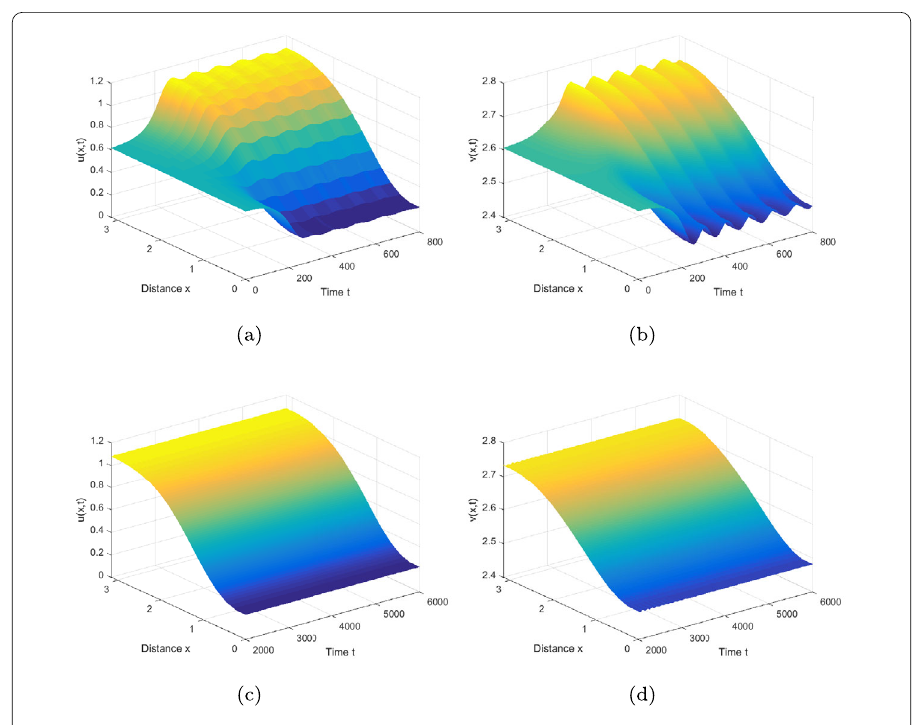
Figure 5 When ( μ 1 , μ 2 ) = (0.4,0.0204) lies in region ③ , system (23) has an unstable constant steady state E 4 (0.6115,2.6044) and a stable nonconstant steady state, where u ( x ,0) = 0.6115 – 0.005cos x , v ( x ,0) = 2.6044 – 0.001cos x . The simulate time is from 0 to 800 in ( a ) and ( b )